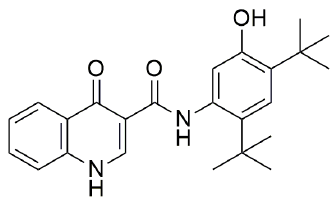
Figure 12. Structure of Ivacaftor.